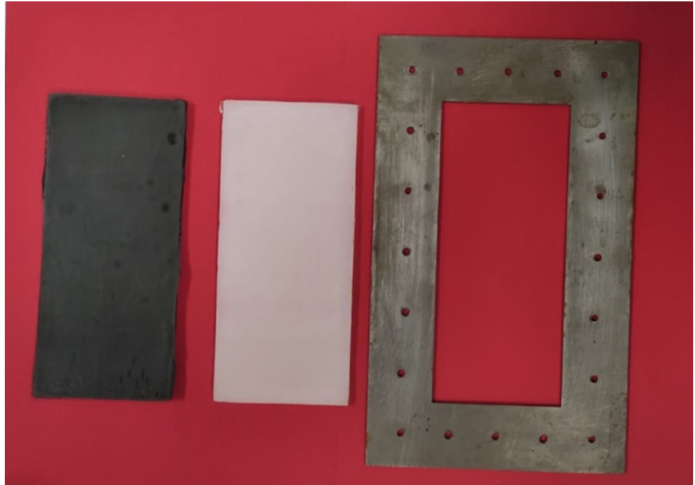
Figure 2. Hot-pressed PAs.